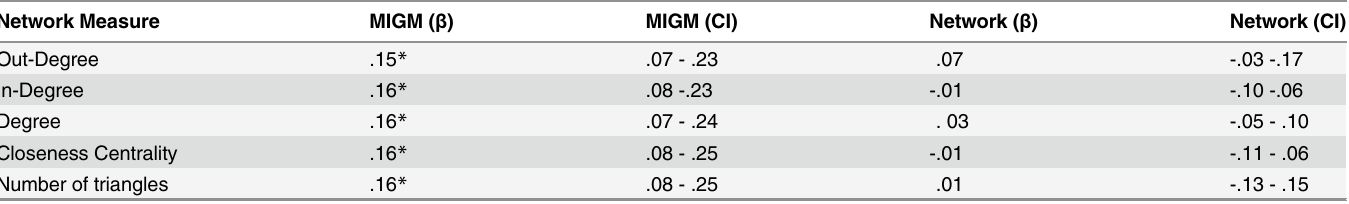
Table 5. Study 2: Standardized betas and confidence intervals of models comparing Multiple Important Group Memberships (MIGM) to individual network measures in predicting personal self-esteem, for children/adolescents in a boys ’ school in Australia. Network